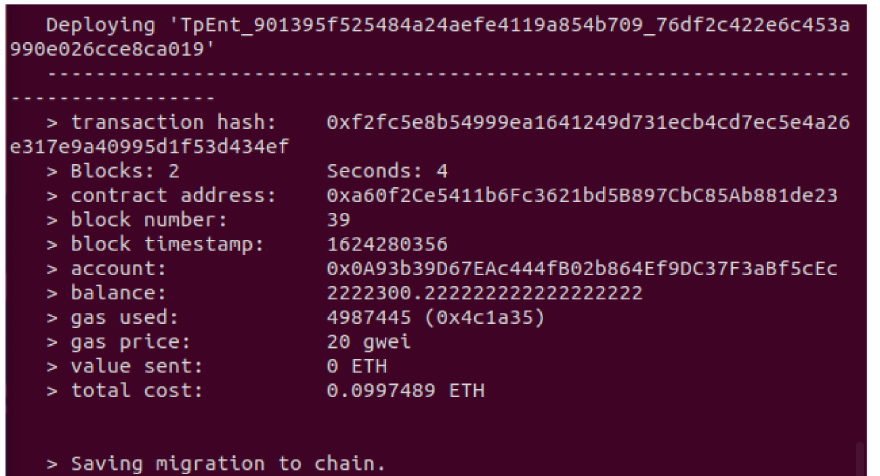
Figure 12. Contract deployment test results from Truffle Command Terminal and Geth